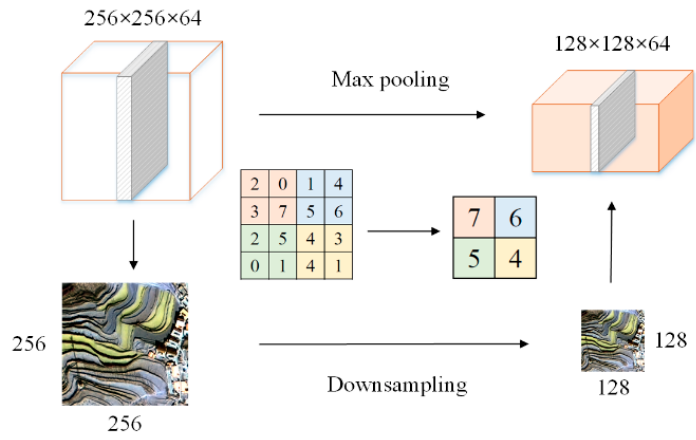
Figure 10. Diagram of pooling